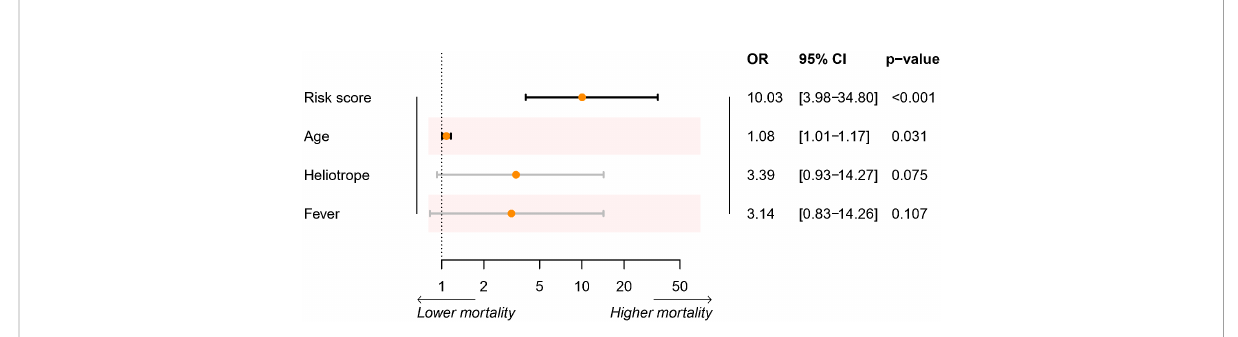
FIGURE 2 Summary of the optimal logistic regression model selected by the stepwise multivariable logistics regression model.